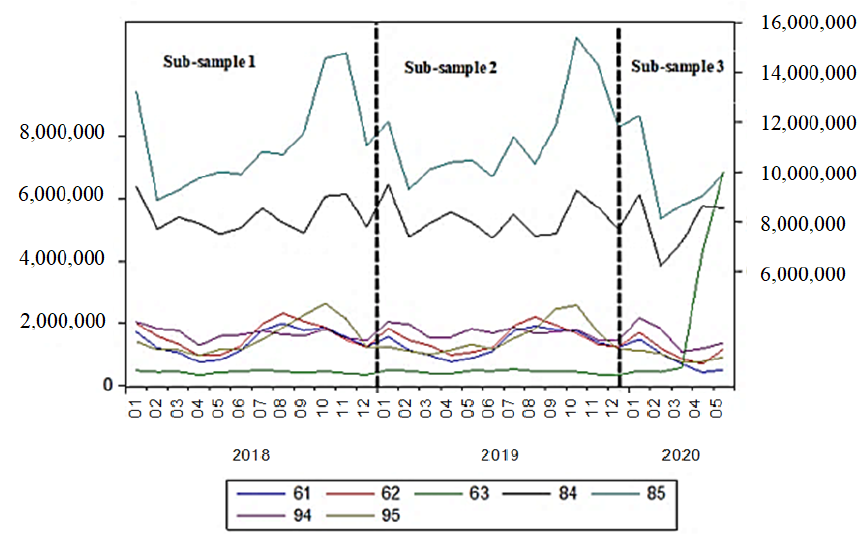
Figure 4. E.U. import values ($) of the selected articles. Source: own investigation.